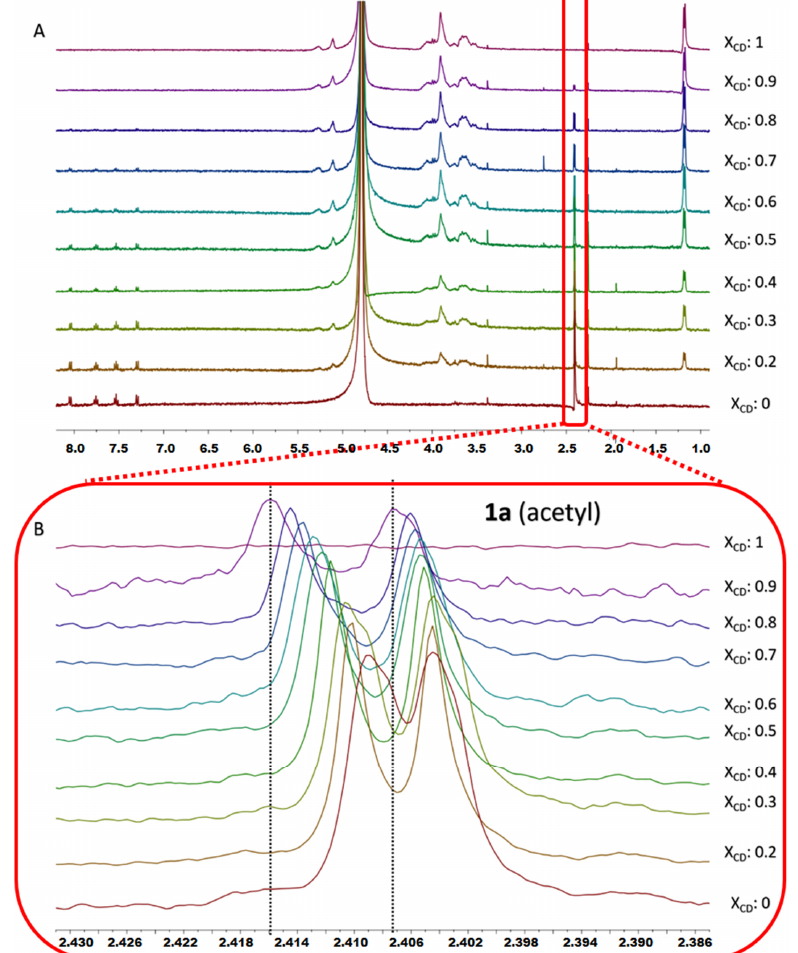
Figure 4. ( A ) 1 H-NMR spectra of different molar fractions of 1a :HP- β -CD and ( B ) expansion of the region of the acetyl protons of 1a .